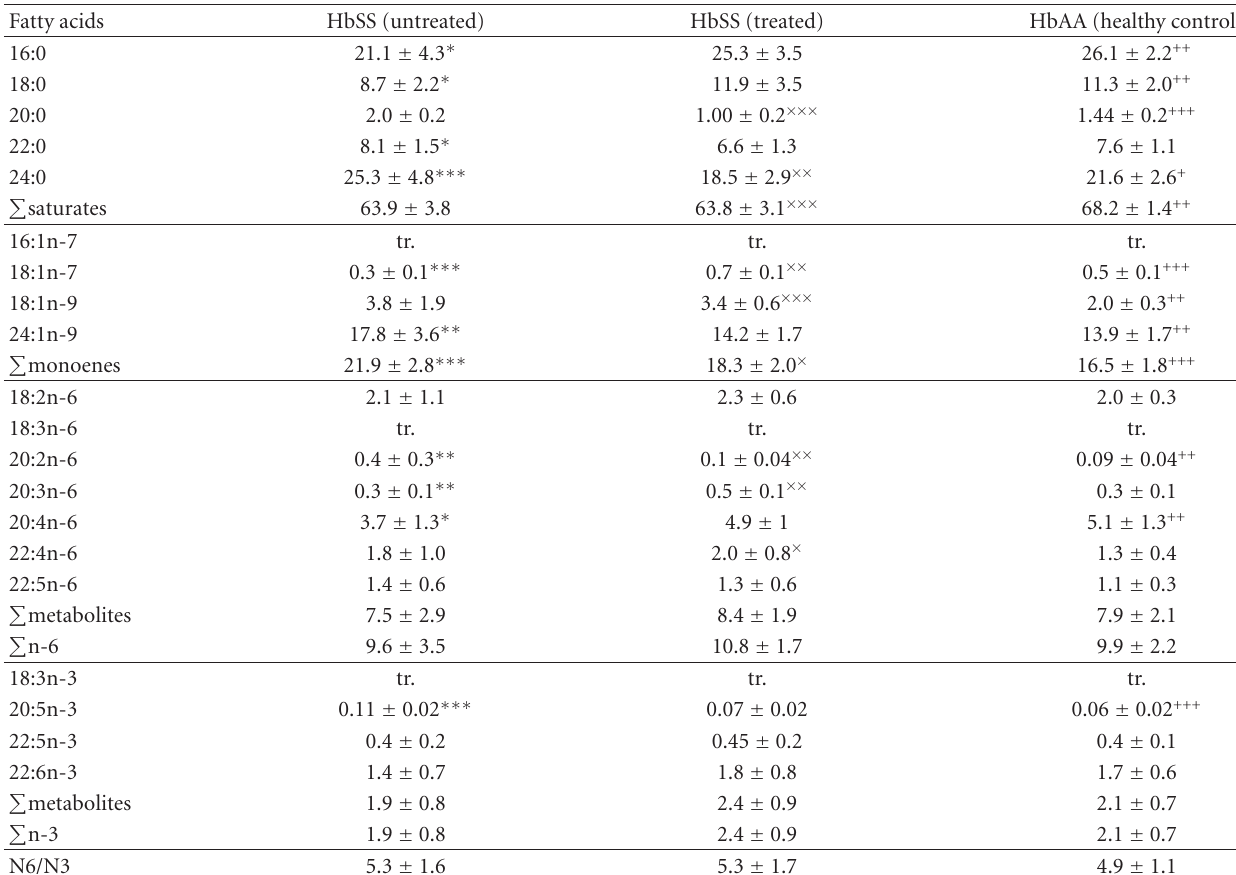
Table 4: Fatty acid composition of red blood cell sphingomyelin of HU-untreated ( n = 17) and treated ( n = 19) HbSS patients and HbAA healthy controls ( n =